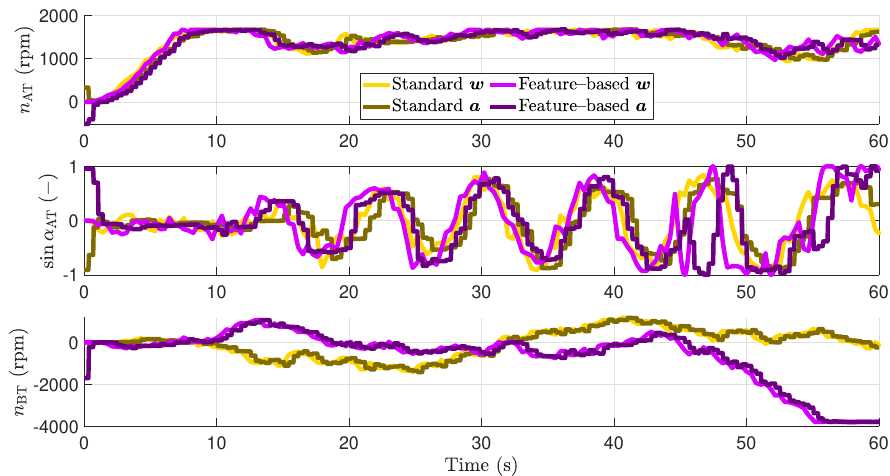
Figure 11. Comparison of the resulting input trajectories of the vessel in the full–scale experiments.